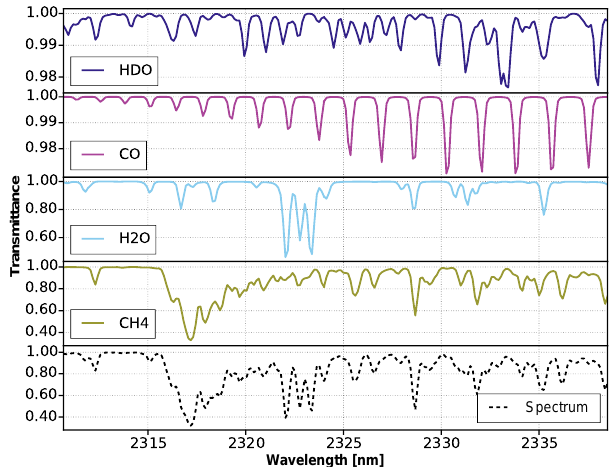
Figure 1. Simulation of atmospheric transmission spectra between 2310.7 and 2338.3nm with a spectral resolution of 0.25nm using HITRAN 2008 spectroscopy (Rothman et al., 2003). Panel 1–4: individual atmospheric absorptions of HDO, CO, H 2 O and CH 4 . Lower panel: total atmospheric